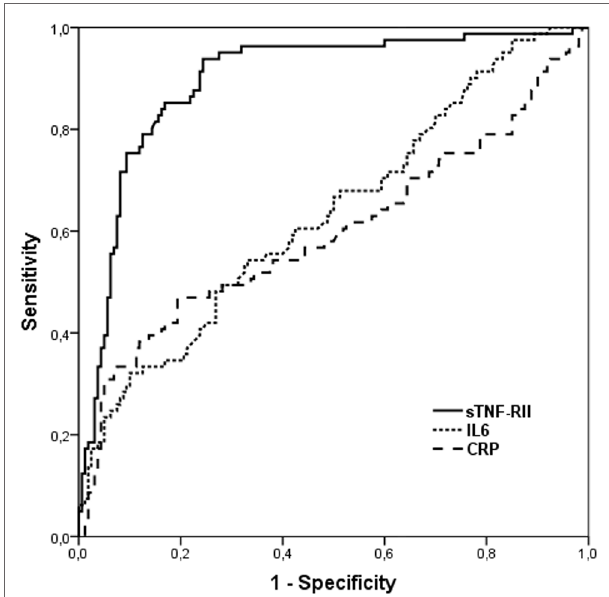
FigUre 2 | Receiver-operating characteristic (ROC) curves for IL6, CRP, and sTNF-RII to predict frailty. Abbreviations: CRP, C-reactive protein; IL6, interleukin 6; sTNF-RII, soluble tumor necrosis factor alpha receptor